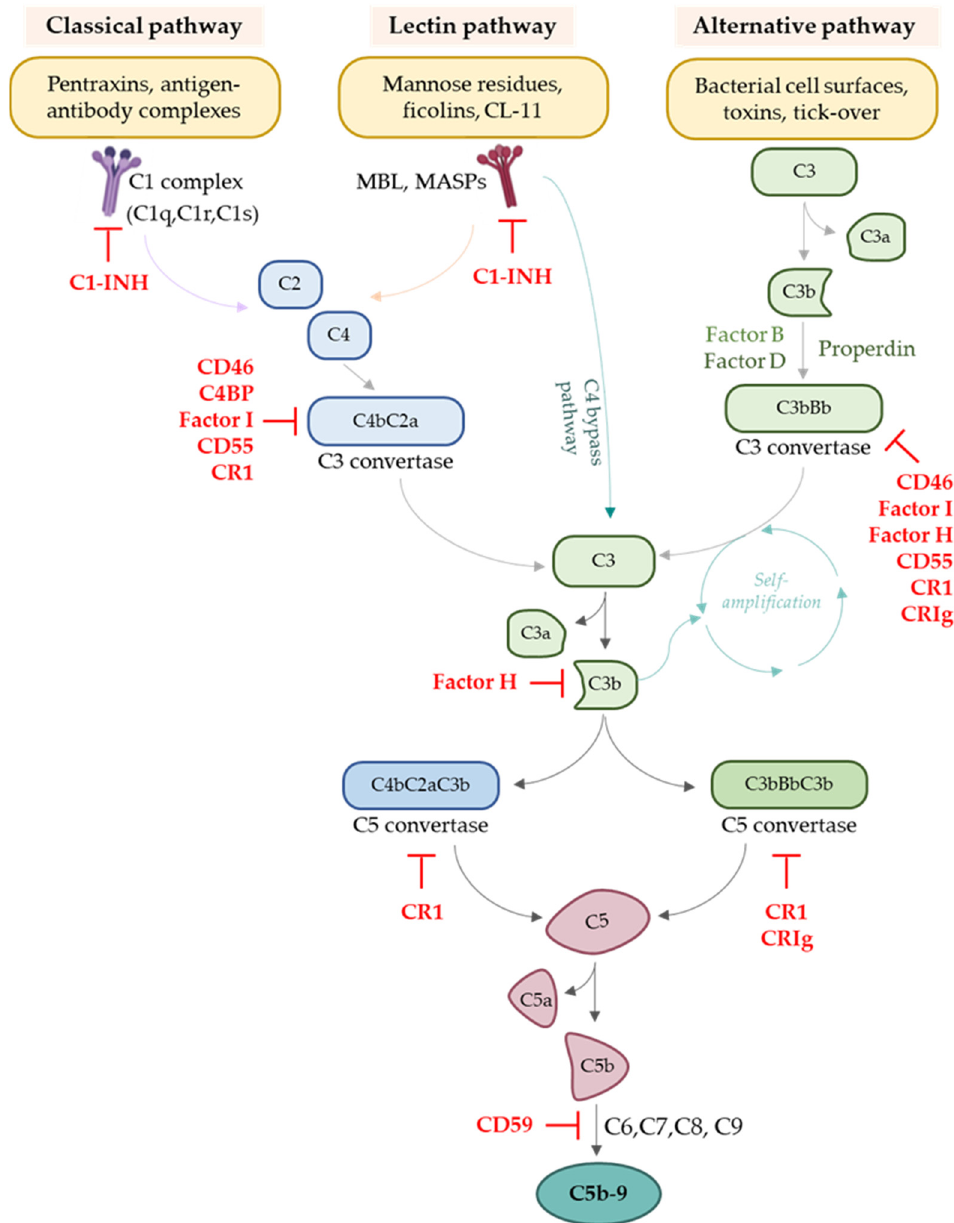
Figure 1. Schematic overview of the complement cascade and of its major ligands and regulators.